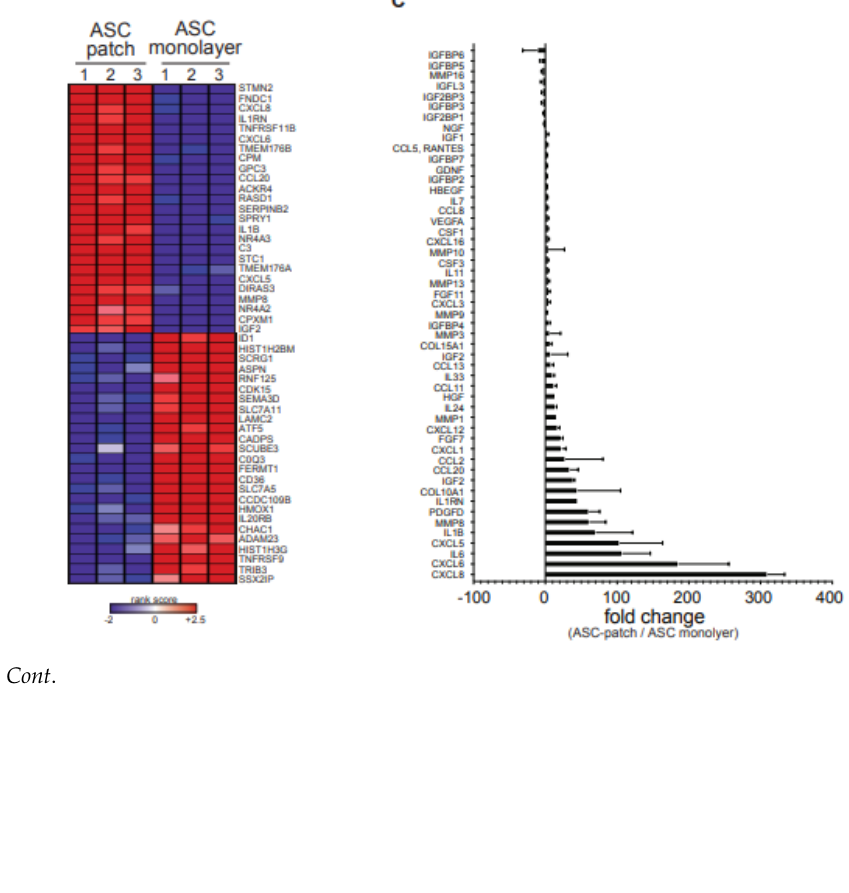
Figure 2. ASCs within the ASC-patch enhanced their regenerative transcriptome . The transcriptome of ASC in gelatin generated from 3 independent donors were assessed by microarray and compared to ASC from the same 3 donors grown in monolayer. ( A ) Heatmap of the top 25 genes with increased expression and the top 25 with decreased expression in the ASC-patch compared with ASC monolayer condition, ranked by Gene Set Enrichment Analysis (GSEA): The regulations considered to be signi fi cant were de fi ned by the calculation of a fold change (> or <2) associated with a signi fi cant p value (<0.05). ( B ) Enrichment pathways determined using the Gene Ontology Biological Process (GOBP) gene set from the Molecular Signature Database are visualized. Heatmap of the top 25 genes with increased expression and the top 25 with decreased expression in SSc EEs compared to healthy donor (HD) EEs, ranked by Gene Set Enrichment Analysis (GSEA). Red dots: up- regulated, blue dots: down-regulated ( C ) Fold change analysis on 215 selected genes involved in wound healing. The 51 statistically signi fi cant regulations are shown (fold change > 2 (up) and <2 (down) and p < 0.05, non-parametric Mann–Whitney t test). Error bars refer to SD.